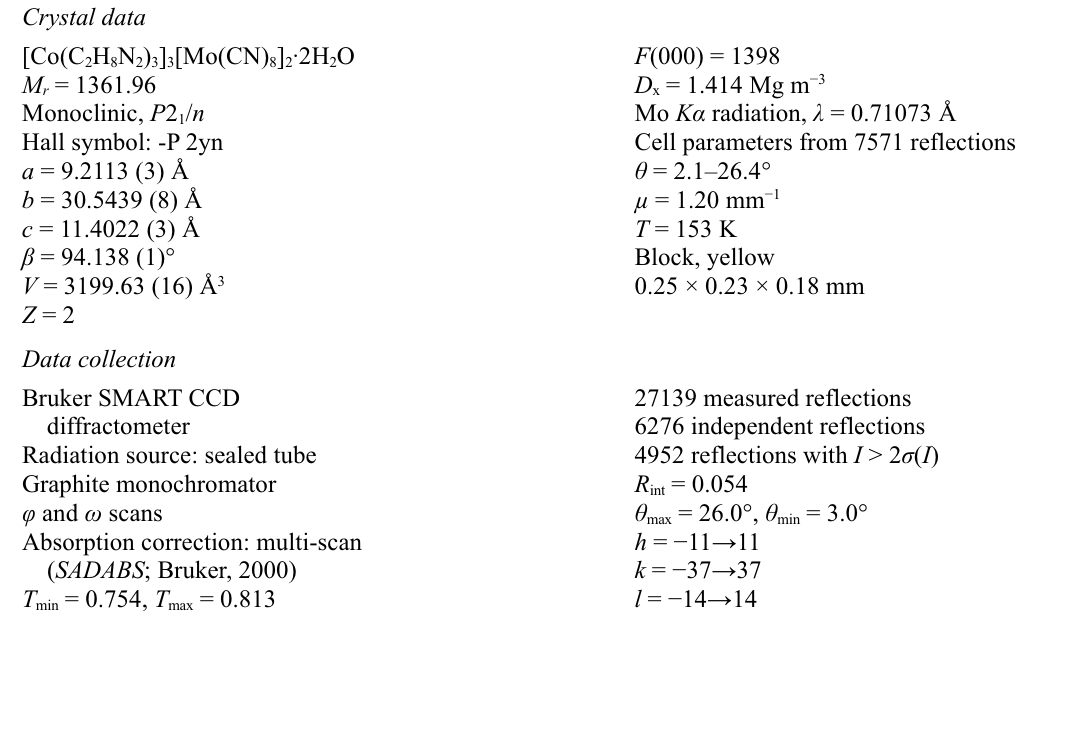
Packing diagram of the title compound presenting a three-dimensional hydrogen bonding network. Tris[tris(ethane-1,2-diamine)cobalt(II)] bis[octacyanidomolybdate(V)] dihydrate Crystal